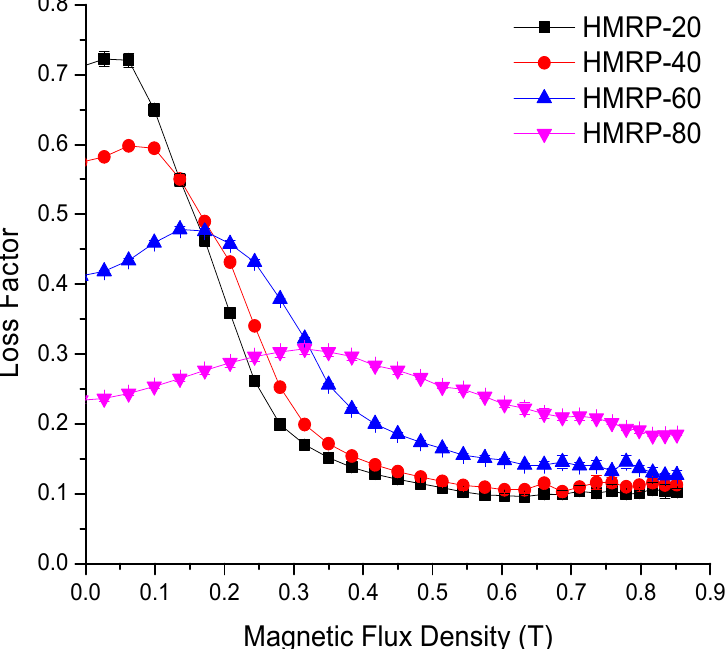
Figure 8. Relationship between loss factor and magnetic flux density for PVA-based MRP samples with different DMSO contents.